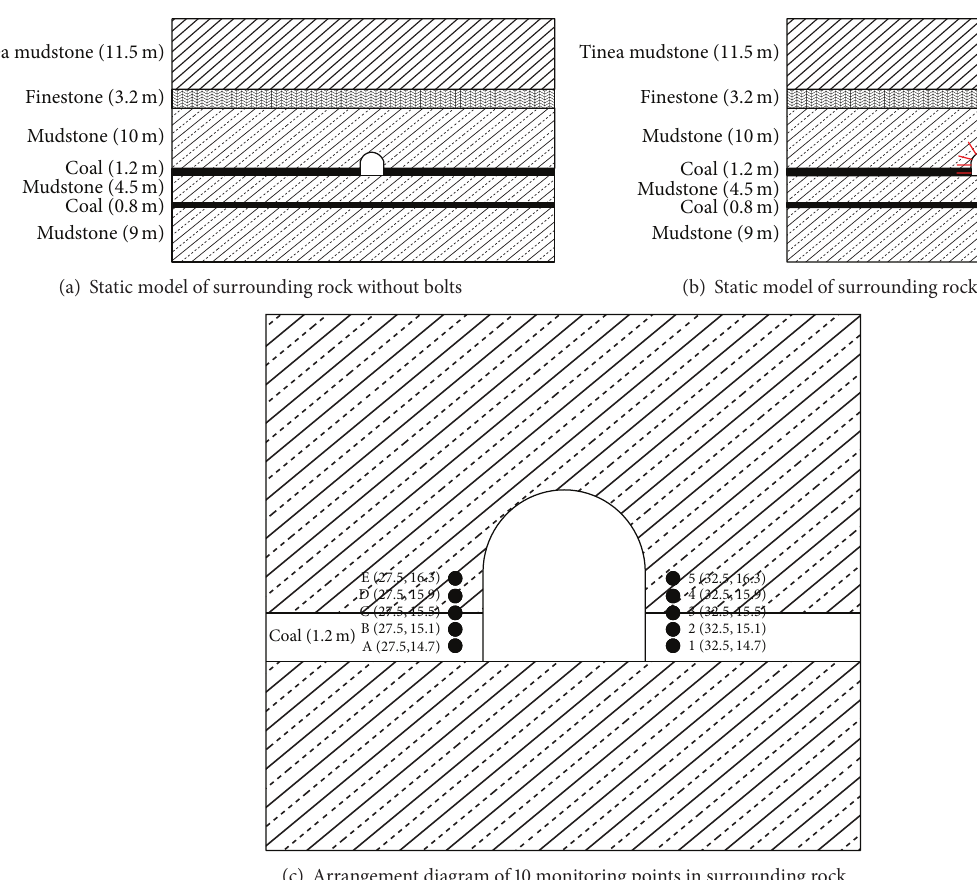
Figure 1: The mechanical models of surrounding rock with or without